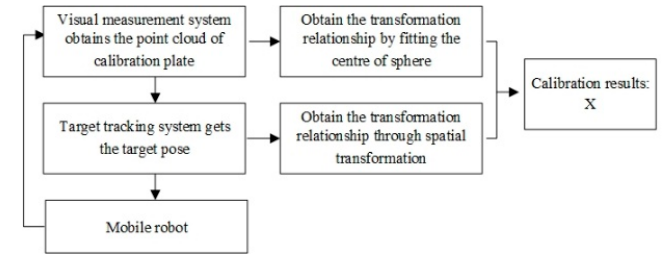
Figure 7. Calibration module